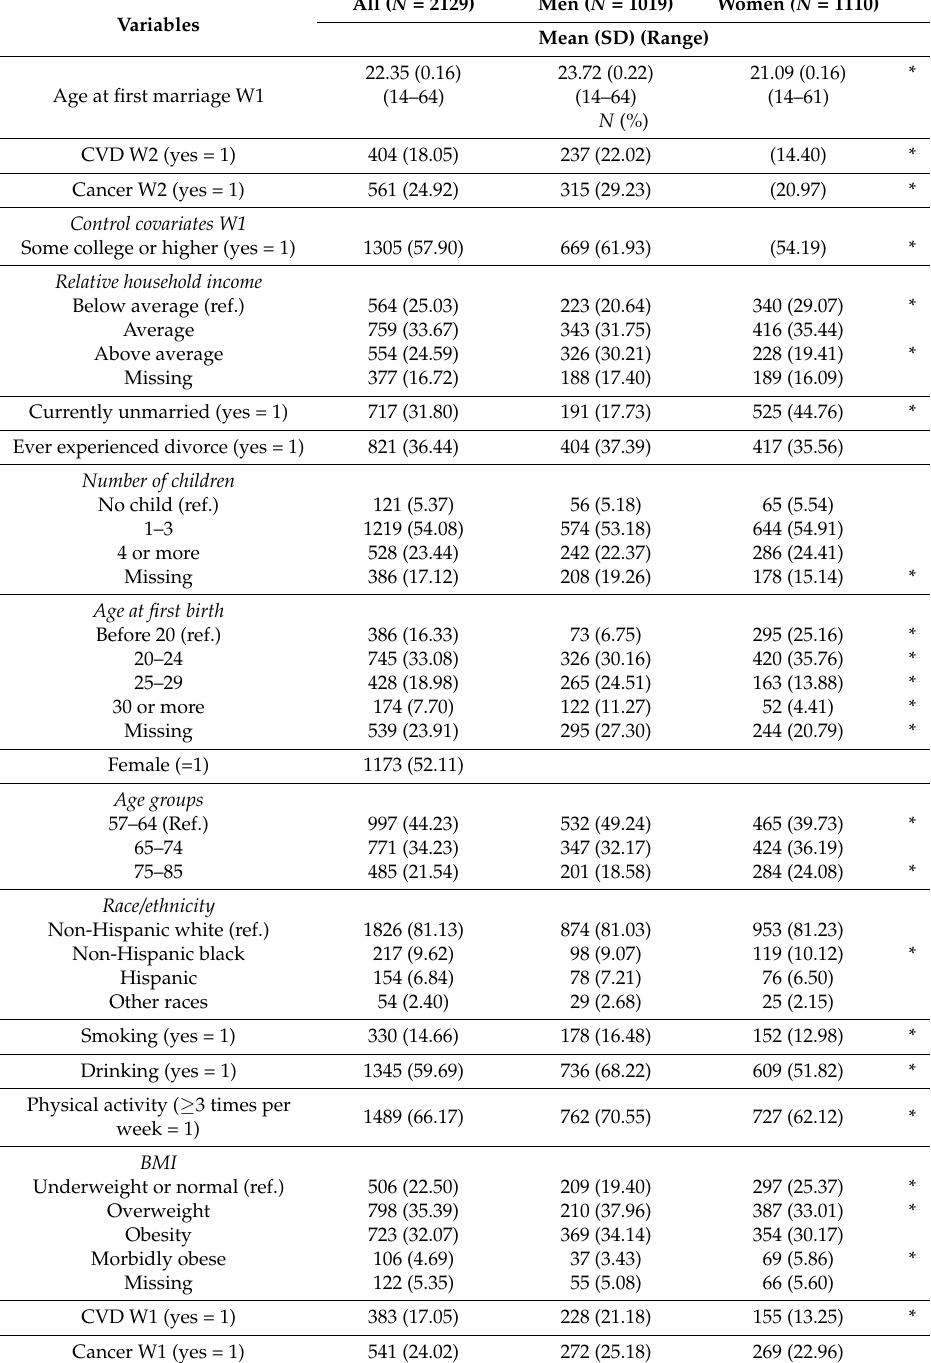
Table 1. Weighted Descriptive Statistics of Analytic